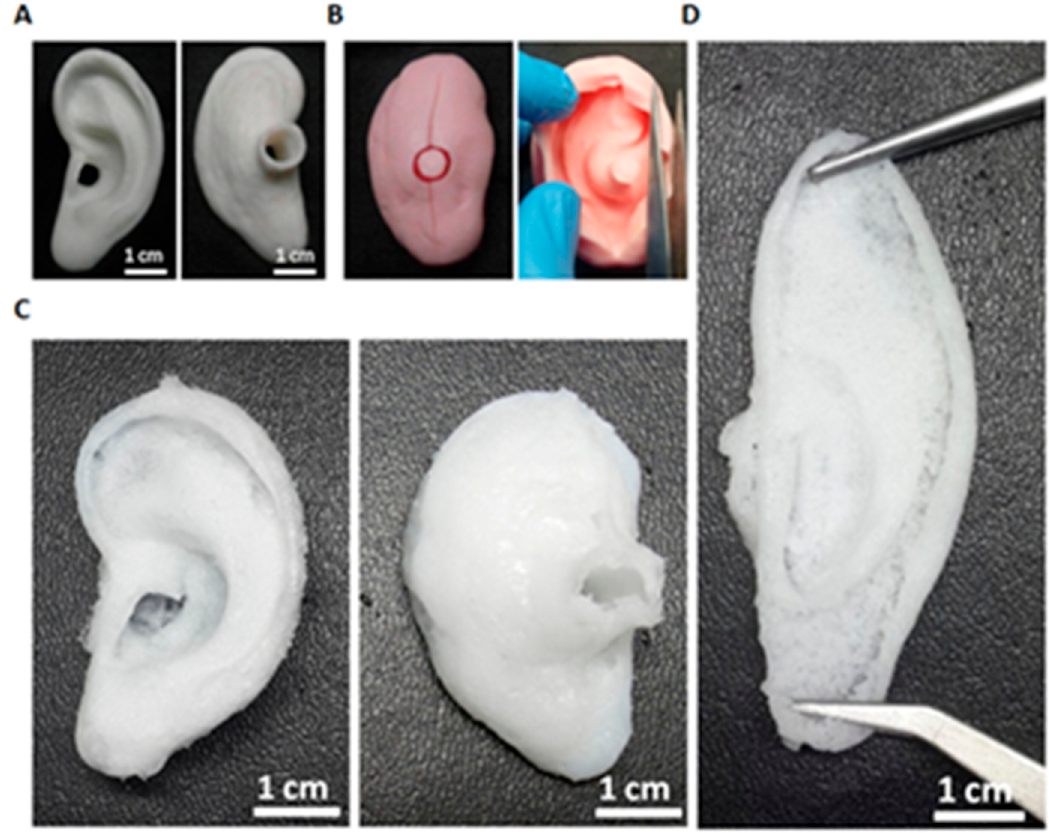
Figure 1. Gross view of the polyvinyl alcohol/silk fibroin (PVA/SF) ear-shaped hydrogel. ( A ) polylactic acid (PLA) molds (front and back views); ( B ) Silicone molds (closed and open views); ( C ) PLA/SF ear-shaped hydrogel (front and back views) ( D ) PLA/SF ear-shaped hydrogel with physical stretching.